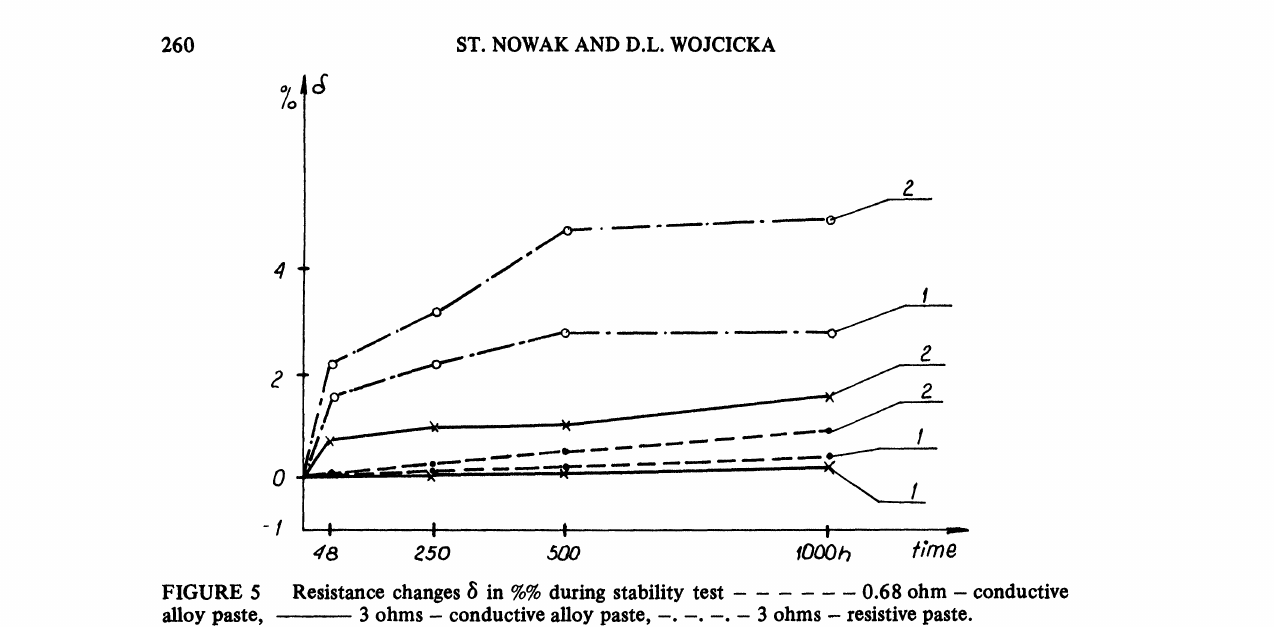
#,9 ZSO 500 O00h f;rne FIGURE 5 Resistance changes i in %% during stability test 0.68 ohm- conductive 3 ohms conductive alloy paste, 3 ohms resistive alloy paste,